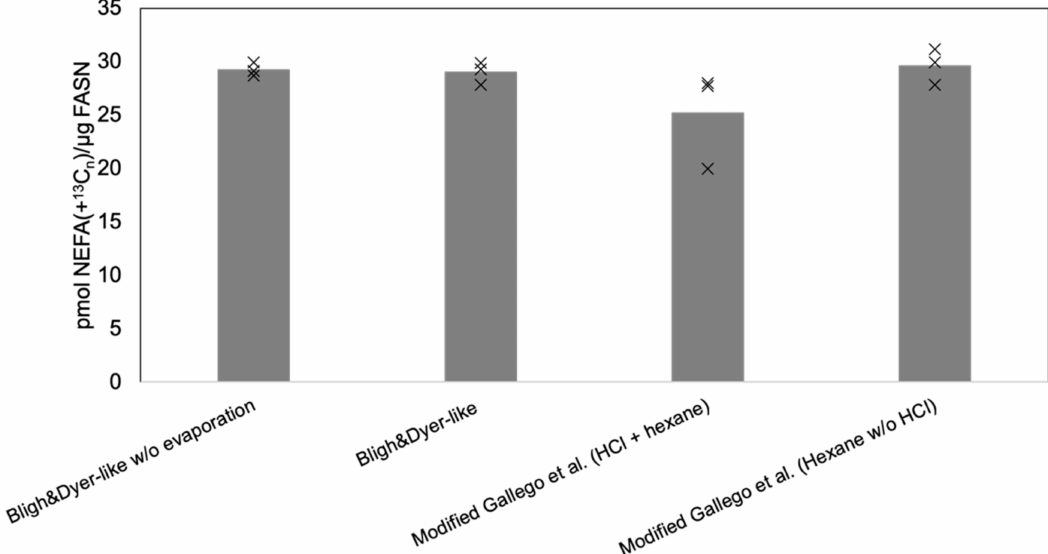
Figure 2. Optimizing the workflow for monitoring FASN activity in vitro. Purified FASN was incubated with 13 C 3 -malonyl-CoA, acetyl-CoA and NADPH at 37 ◦ C for 10 min. The reaction mixtures (200 µ L), with de novo synthetized 13 C-labeled NEFAs, were processed using one of the four indicated strategies (see the Results and Material and Methods sections for details). Deprotonated NEFAs were detected by negative ion mode FTMS using an LTQ Orbitrap XL mass spectrometer and quantified using the internal NEFA 16:0( + 2 H 4 ) standard and normalized to the amount of FASN. Data represent average values and dots individual measurements ( n = 3 independent reactions extracted and analyzed